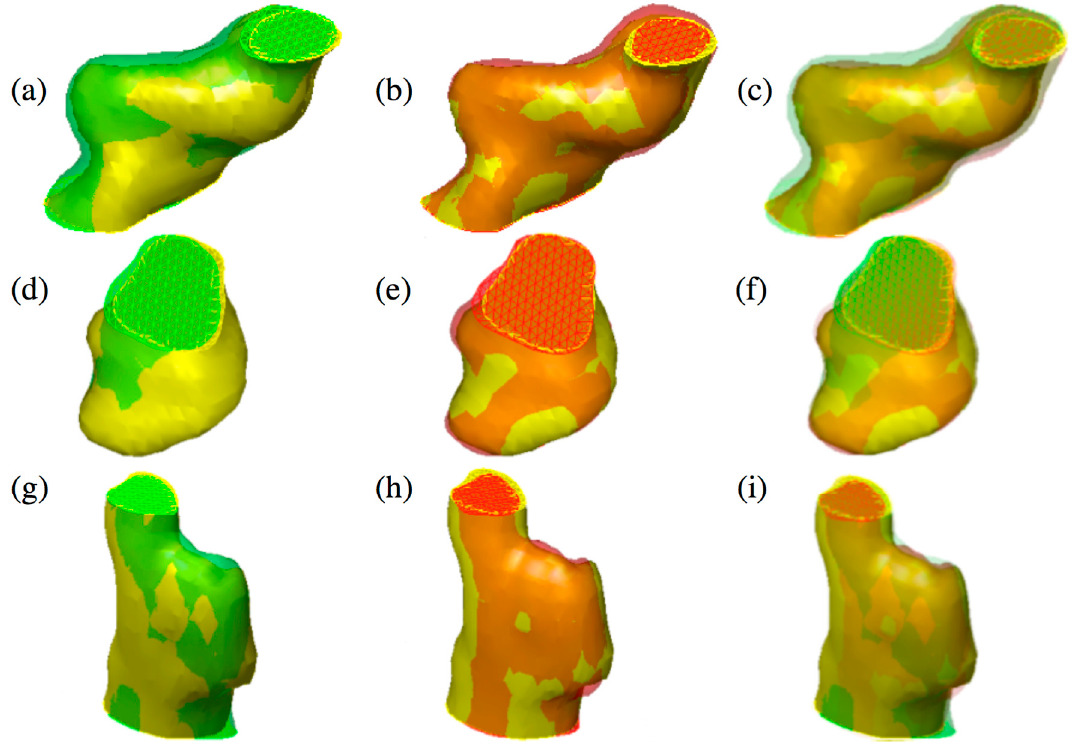
Figure 3. Three different tumors reported in the figure show the difference between 2D active contours ( a , d , g ) [24] and 3D active surface ( b , e , h ) segmentations guided by the 3D classifier. The reconstructed surfaces (green and red) and the gold standards (in yellow) are rendered partially transparent for better comparison. In the last column, the overlap of both methods and the gold standard is shown ( c , f , i ). Specifically, an over-segmentation of the 2D approach compared to 3D can be observed. (Color images can be found on the electronic version of this article).